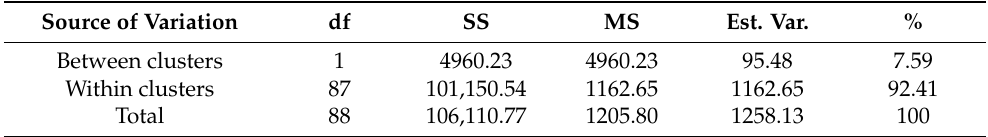
Table 4. Analysis of molecular variance (AMOVA) of the genetic variation between and within two clusters of 89 accessions of tarwi. Source of Variation df SS MS Est. Var. % Between clusters 1 Within